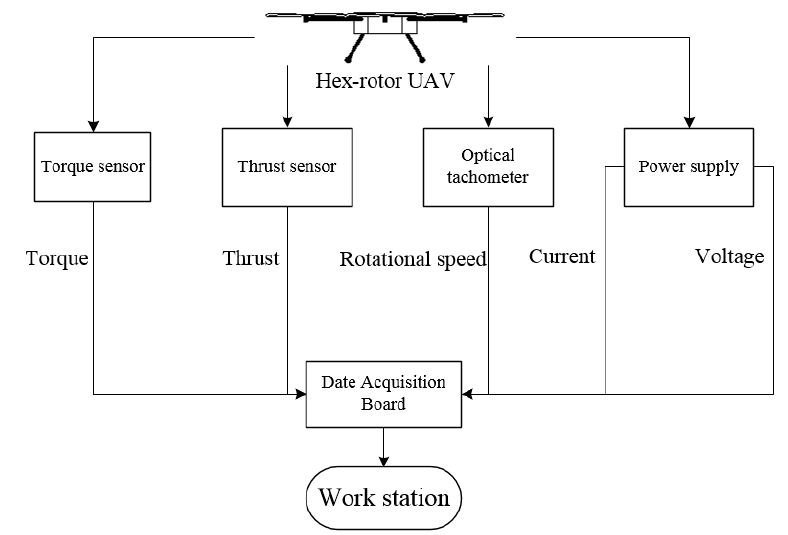
Figure 2. Experimental setup.